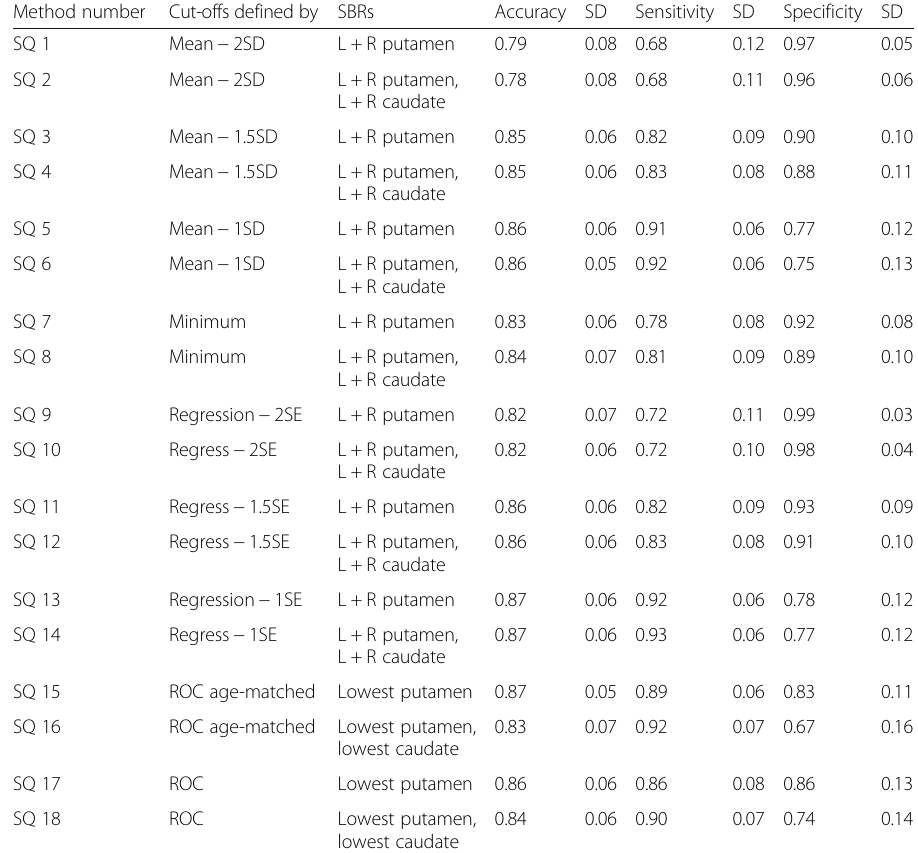
Table 4 Semi-quantitative results for local clinical data Method number Cut-offs defined by